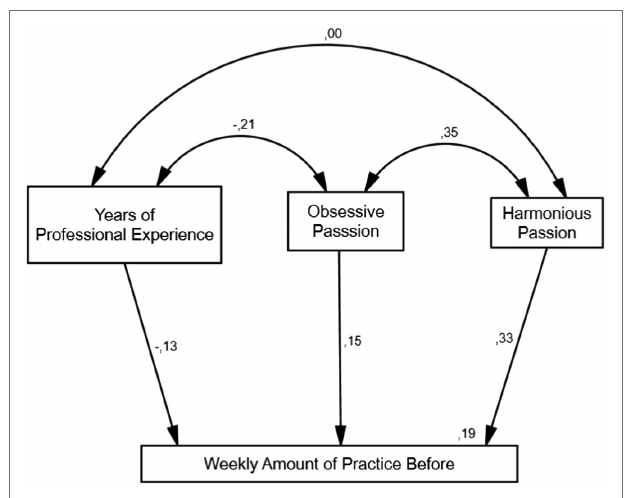
FIGURE 1 | Model before the pandemic for Europe and Latin